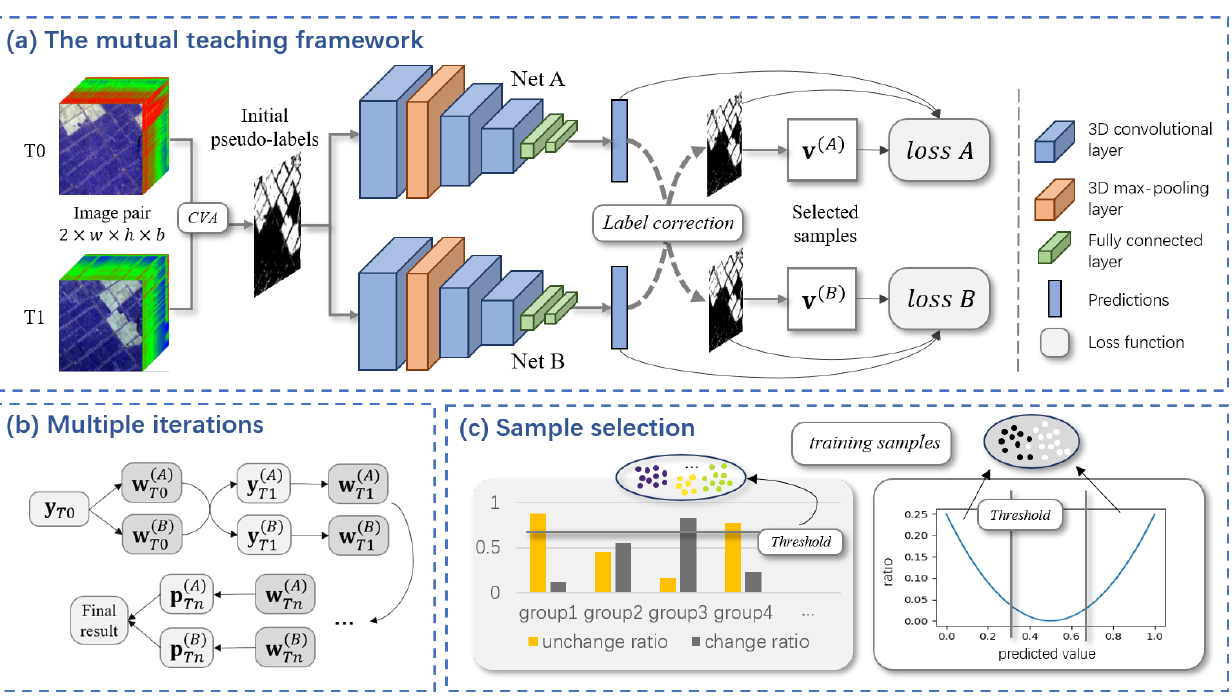
Figure 2. Graphical illustration of the proposed method. ( a ) Overall framework of the proposed mutual teaching based on collaborative training and label correction. Both models update their pseudo-labels with each other’s predictions and select clean samples to optimize parameters. ( b ) The model parameters and pseudo-labels are alternately updated and the final result is generated by the predictions of the two models. ( c ) Two sample selection methods jointly ensure the accuracy and diversity of training